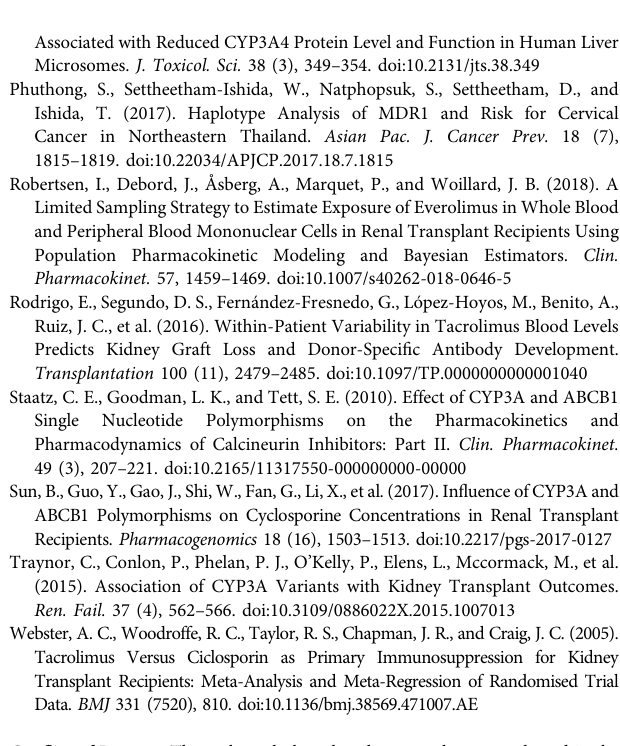
Signi fi cance level: p -value < 0.05. See genetic polymorphisms details in Supplementary Table S1 . Supplementary Figure S4 | TAC-Dose associations to CYP3A5 polymorphism. (A) Co-dominant model. (B) Dominant model. (C) Recessive model. TAC: tacrolimus. Signi fi cance level: p -value < 0.05. See genetic polymorphisms details in Supplementary Table S1 . Supplementary Figure S5 | CsA Dose/weight per genotype. Repeated-measured ANOVA. W1: week 1. W2: week 2. W4: week 4. Signi fi cance level: p -value < 0.05. See genetic polymorphisms details in Supplementary Table S1 . Supplementary Figure S6 | TAC Dose/weight per genotype. ANOVA test and T test. Signi fi cance level: p -value < 0.05. See genetic polymorphisms details in Supplementary Table S1 . Supplementary Figure S7 | TAC-Dose associated to MDR1 TTT haplotype. MDR1 haplotype con fi gured by C3435T, C1236T, and C2677T/A. Signi fi